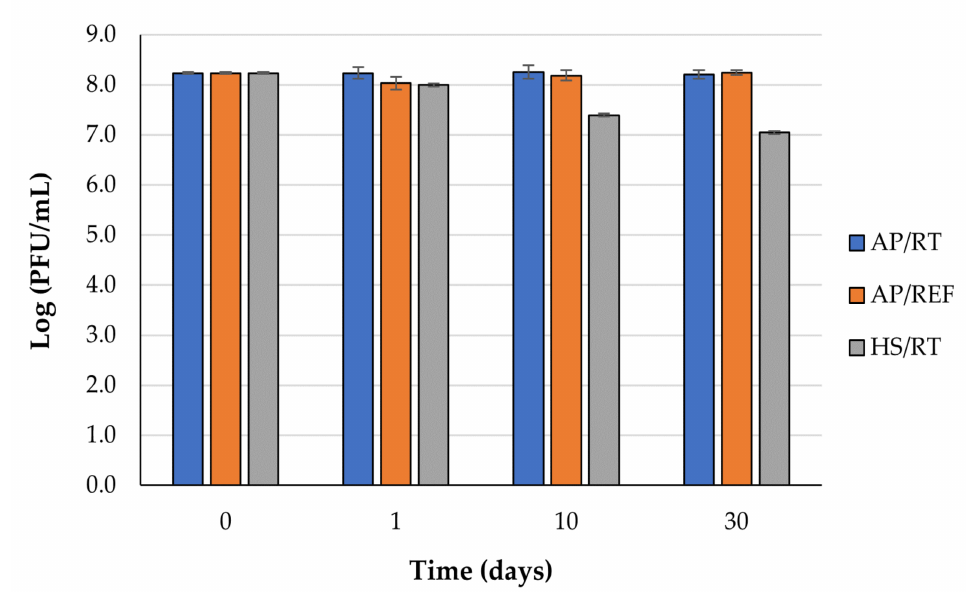
Figure 3. Phage phT4A viability under atmospheric pressure at room temperature (AP/RT) and refrigeration (AP/REF), and 75 MPa pressure at RT (HS/RT) for 30 days. 3.3. Effect of Phage phT4A and Hyperbaric Storage on the Inactivation of E.